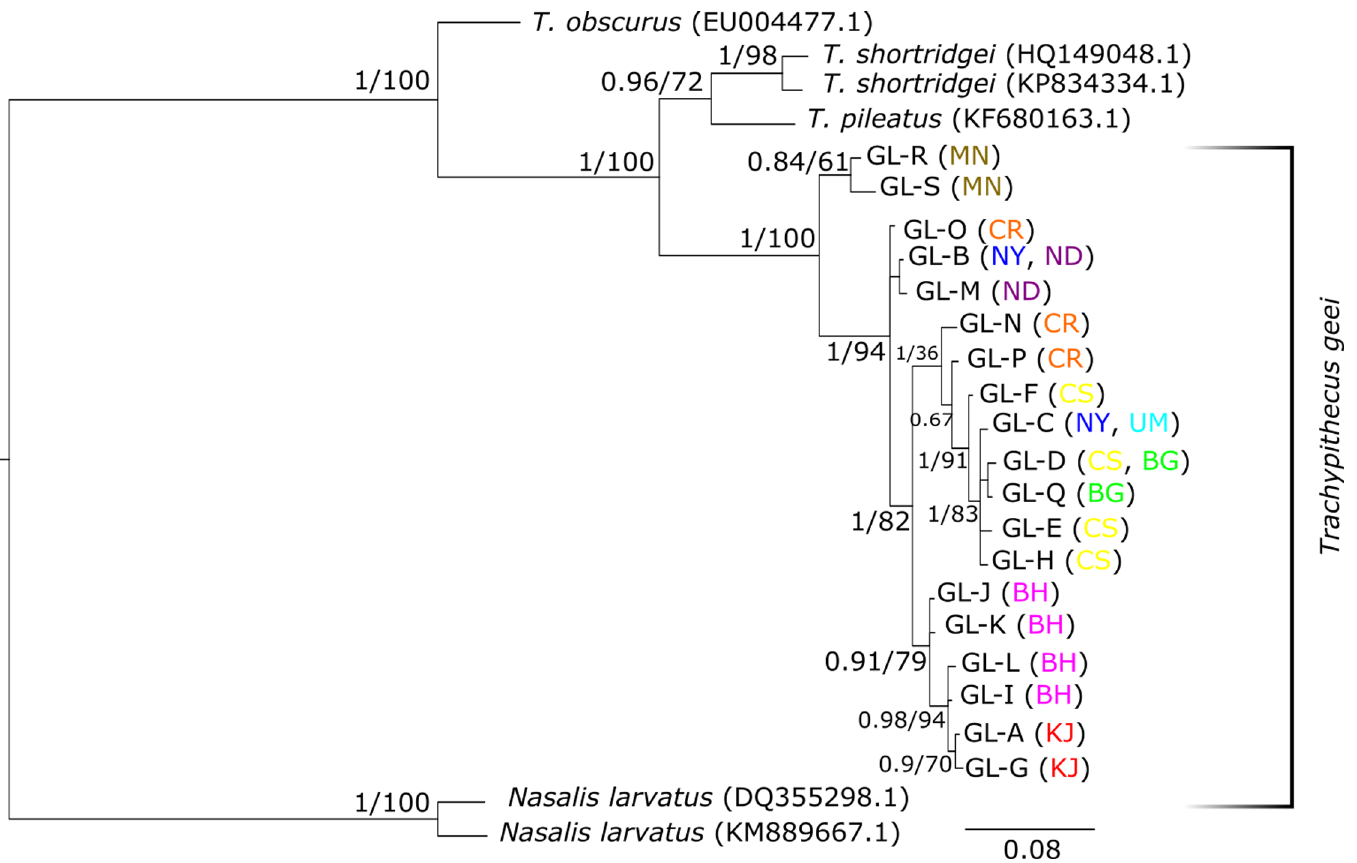
Fig 3. Bayesian Inference tree of hypervariable region-I. Bayesian inference tree reconstructed from 518 bases of HVRI. Leaves are labelled with the species and accession codes in parentheses and, for golden langurs, haplotype codes followed by the fragment(s) of origin in parentheses. The numbers at each node are the Bayesian posterior probabilities followed by bootstrap values of the corresponding nodes (where present) in the maximum likelihood tree.